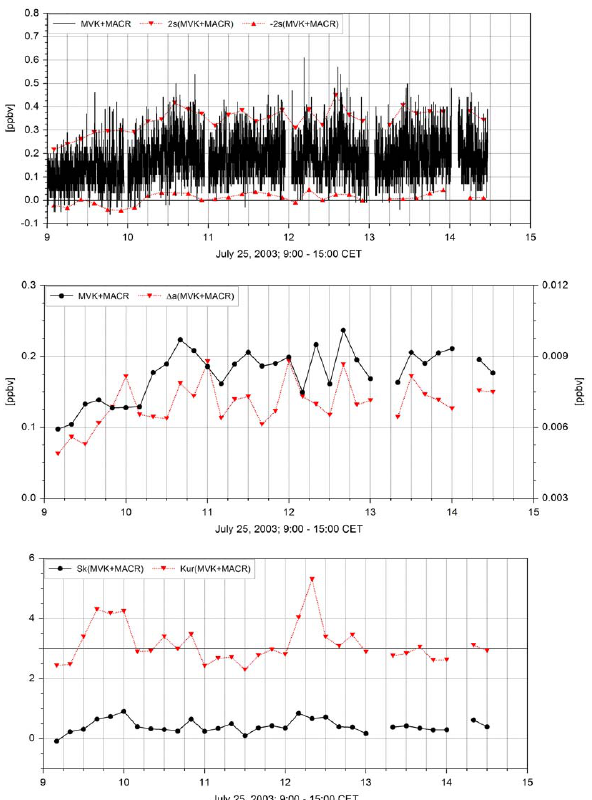
Fig. 6e. Mixing ratio of methyl vinyl ketone + methacrolein (MVK+MACR; in ppbv) with the ± 2 σ -limits, the mean value, the standard error 1a (right ordinate), the skewness Sk and the kurtosis Kur , measured at 37m height by PTR-MS on 25 July 2003, 09:00–15:00CET.